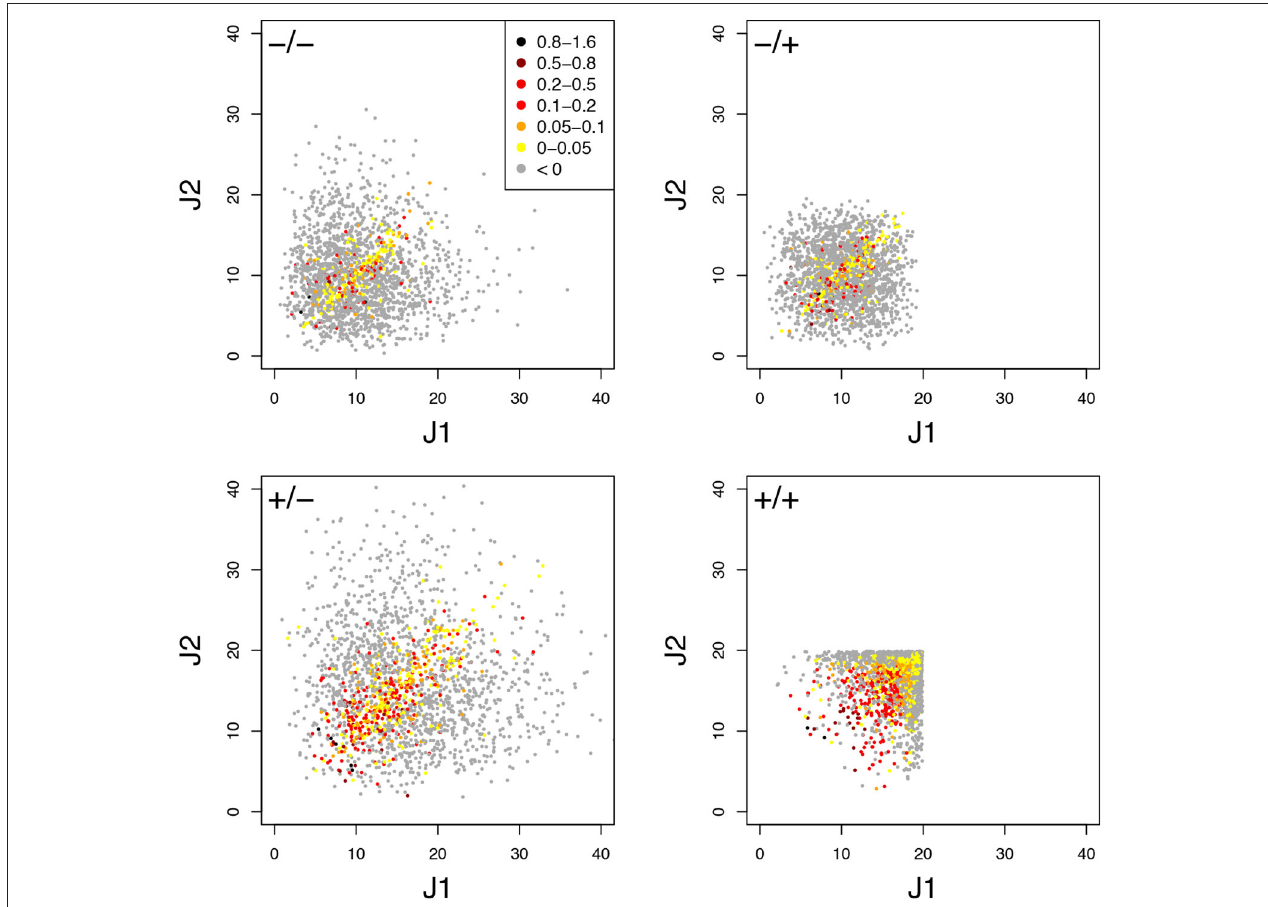
FIGURE 8 | Relationship between parental fluxes J 1 and J 2 and hybrid fluxes under four simulation conditions. Each point corresponds to a hybrid, with warm colors when there is BPH ( H BP > 0).